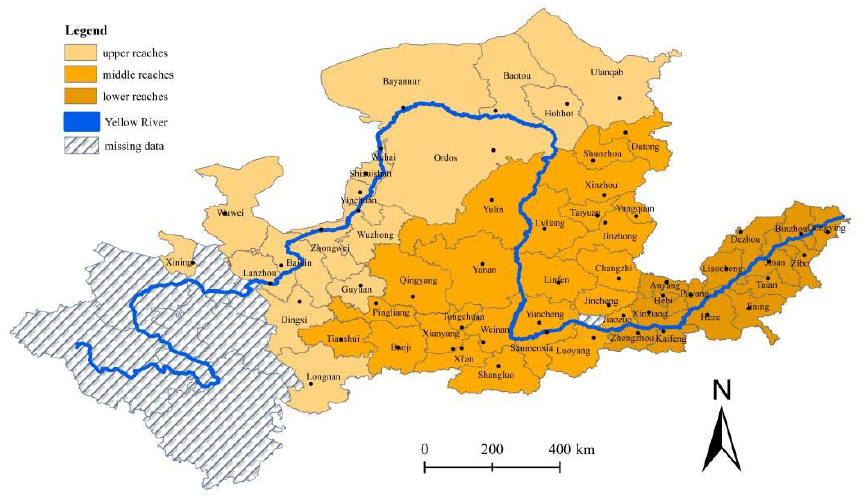
Figure 2. The research areas.